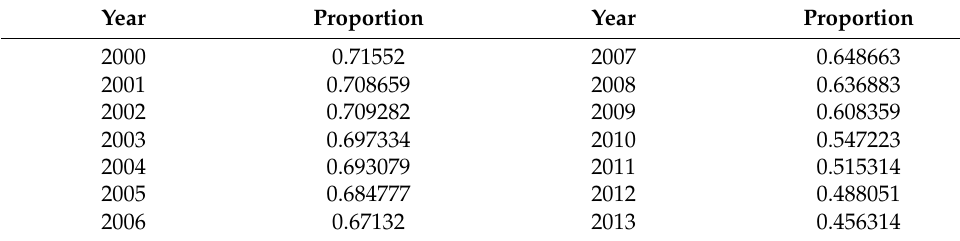
Table 5. Proportion of diesel